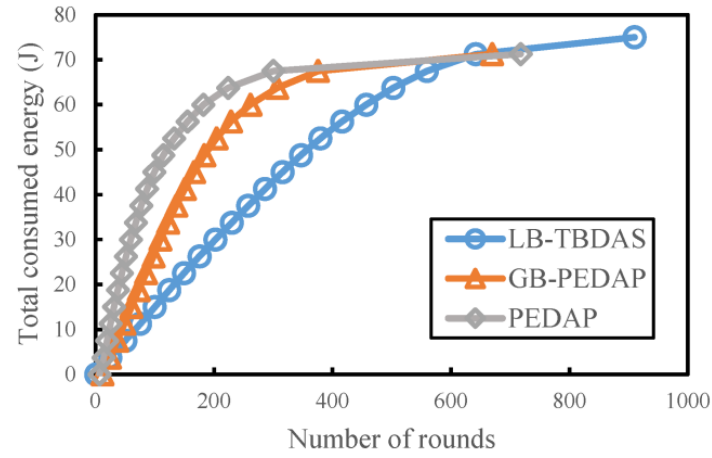
Figure 8. Total consumed energy versus number of rounds.